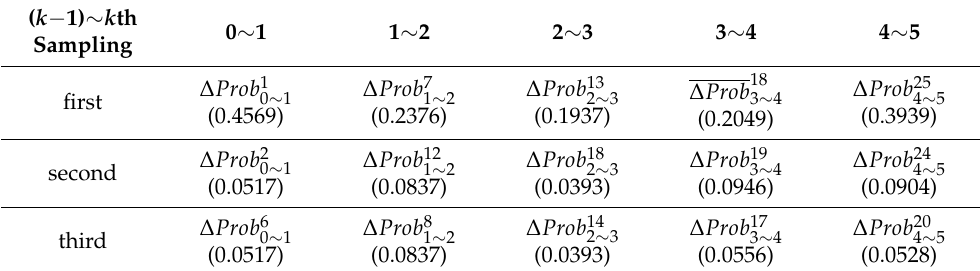
Figure 8. The distribution of ∆ Prob z of Input 01~02 for Route 03: ( a ) 0 ∼ 1st sampling interval, ( b ) 1 ∼ 2nd sampling interval and ( c ) 2 ∼ 3rd sampling interval.